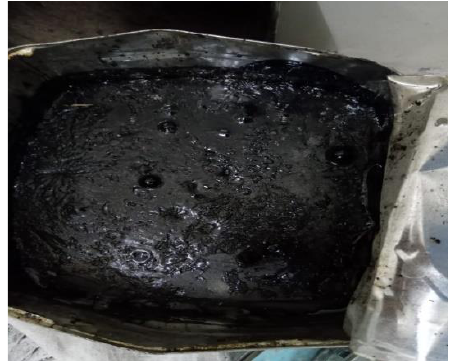
Figure 2. 80/100 grade of bitumen used in the study. Table 2. Properties of the bitumen with standard specifications.